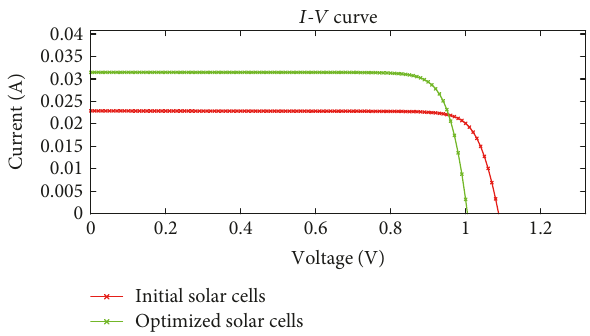
Figure 10: Comparison between the original and optimized I - V characteristic solar cells. Table 5: Comparison between our optimized GaAs solar cell and others cells from